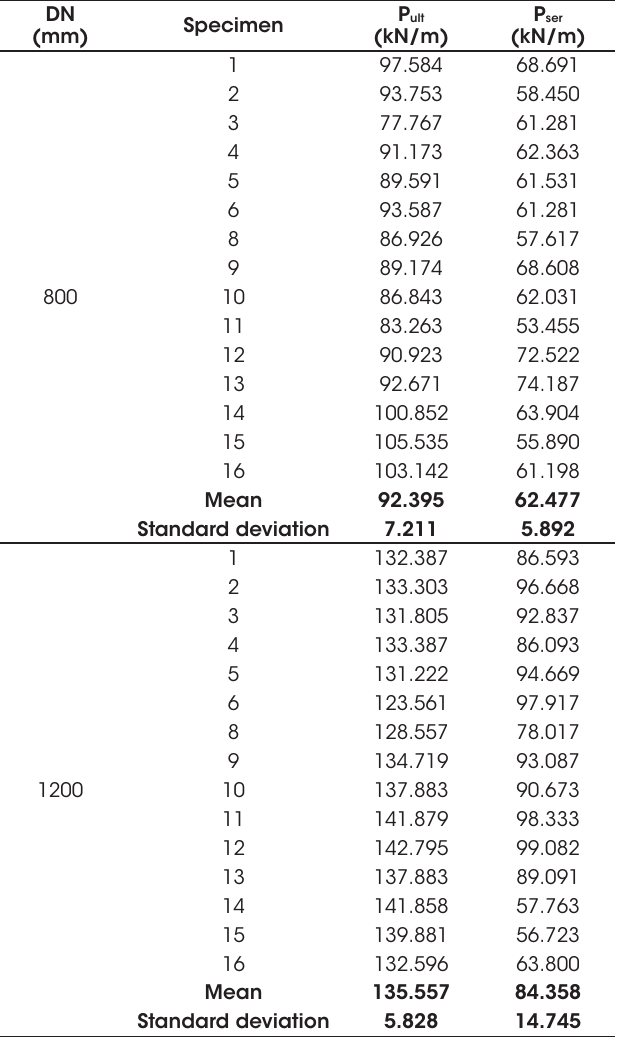
Basic statistics of the reinforced concrete pipes experiments